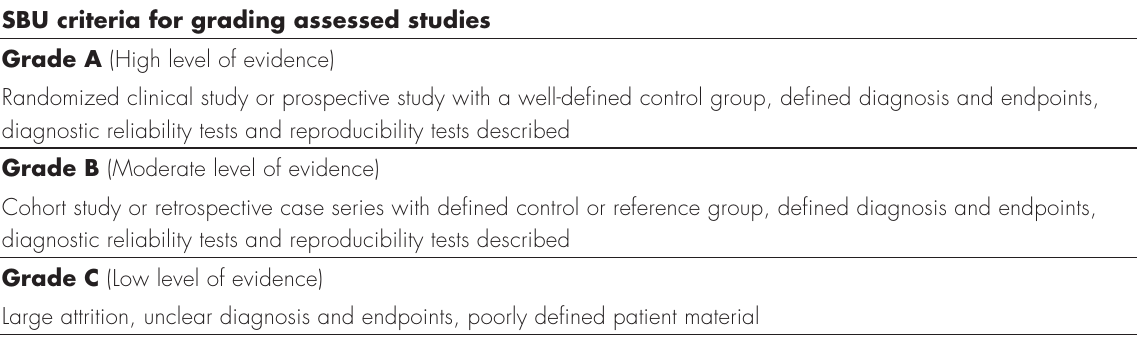
(Table II) and, based on the score assigned to each study, the review level of available evidence was further scored into four grades (1,2,3,4) (Table III).